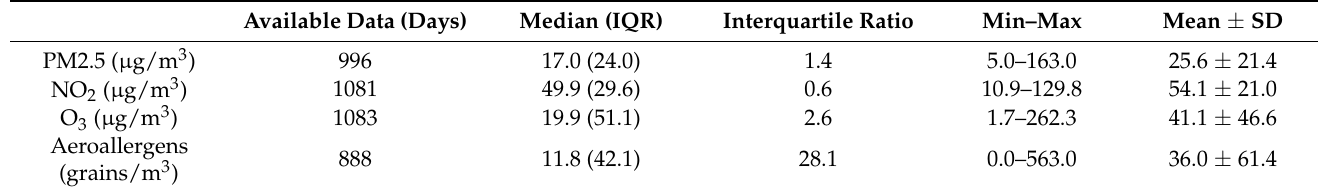
Table 2. Distribution of daily concentrations of air pollution and aeroallergens during the three years